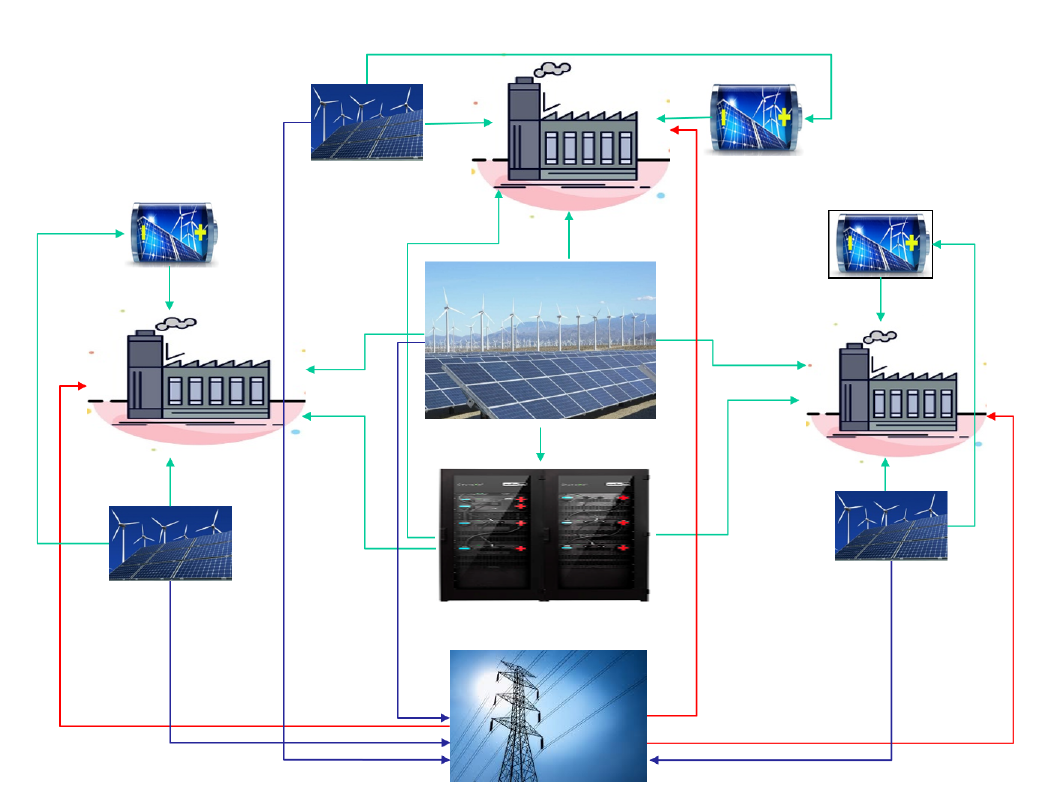
Figure 2. Schema of configuration CF − 9 for a case of three factories